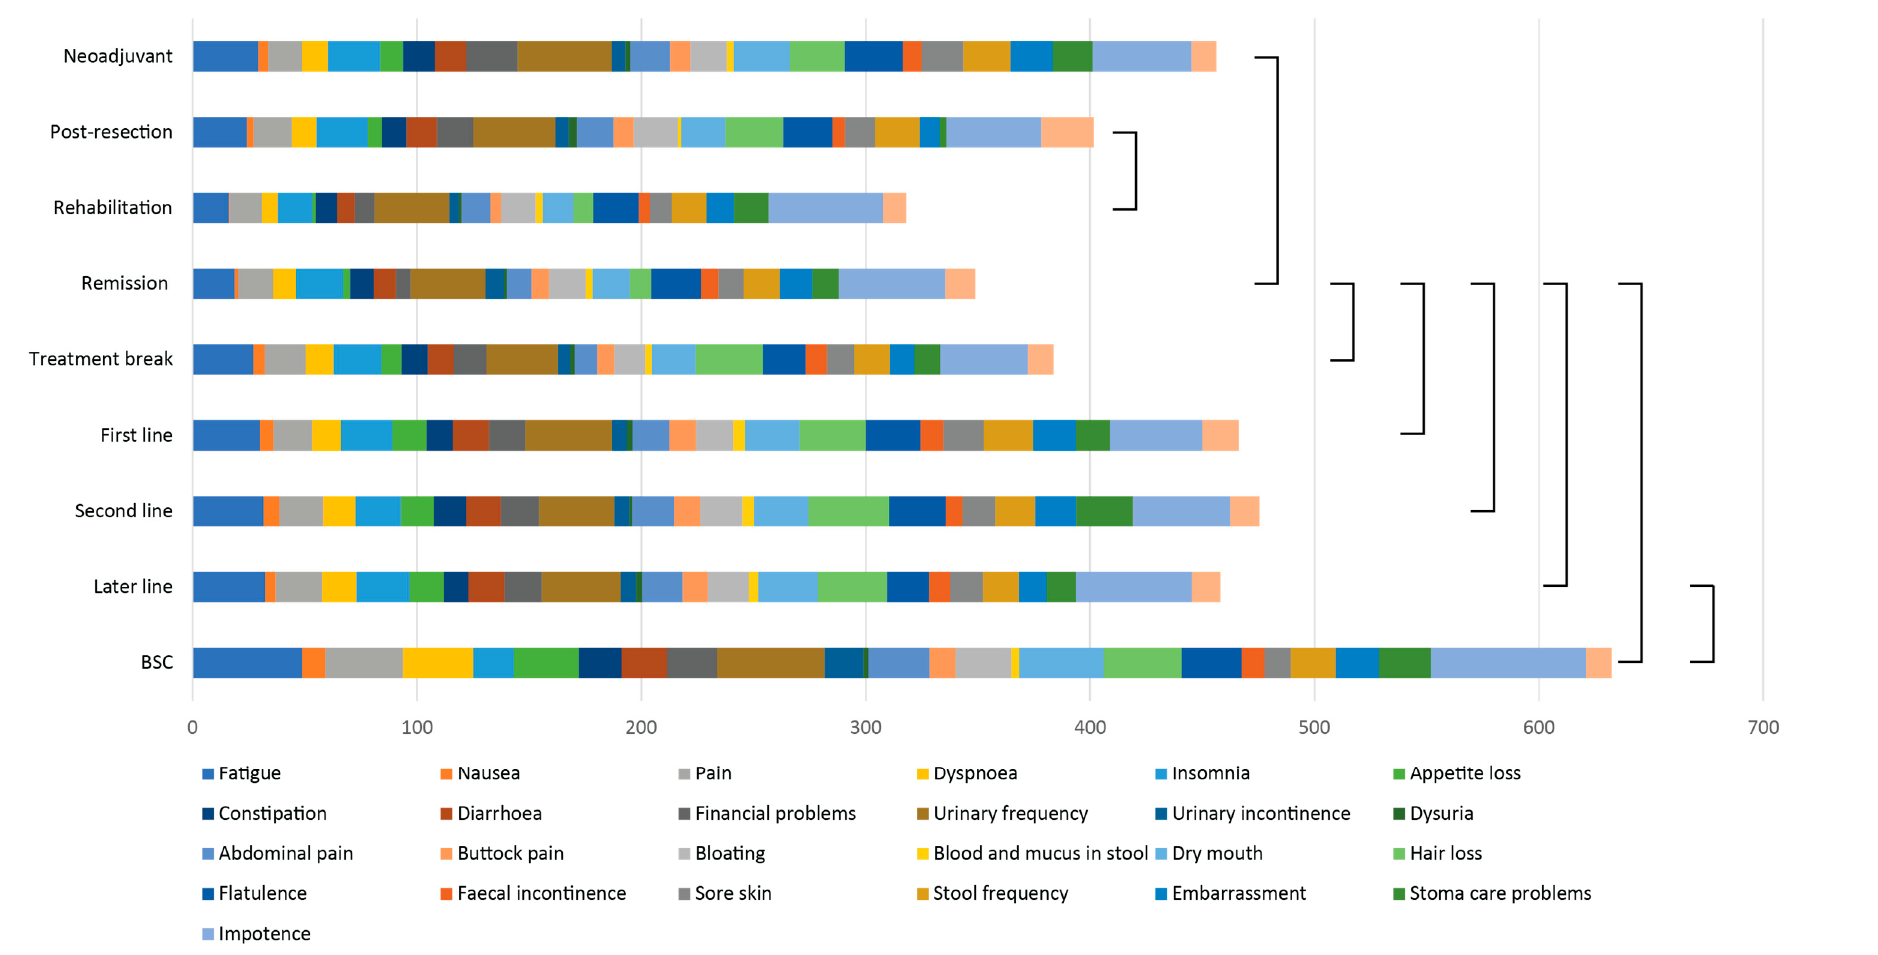
Figure 4. Symptom burden as sum of 26 symptom scales measured with the QLQ-C30 and QLQ-CR29 during different treatment phases. Statistically significant differences between treatment phases are marked with brackets. Abbreviations: BSC = Best Supportive Care.